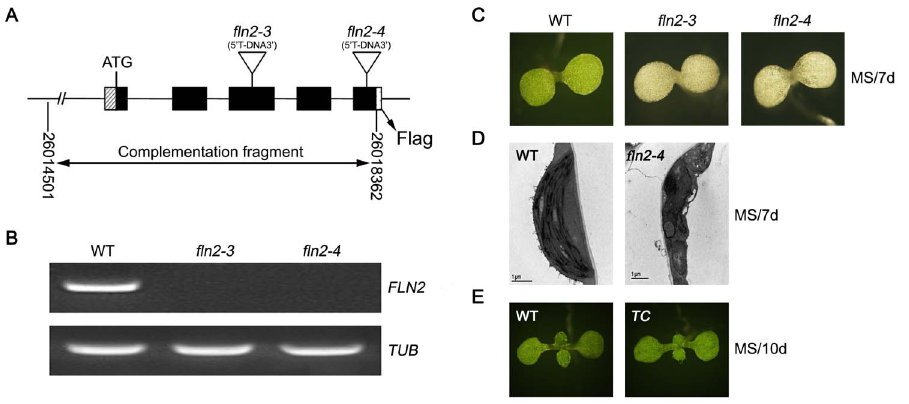
Figure 1. T-DNA insertion sites of fln2 and their phenotypes. (A) The sketch map of the FLN2 gene, the T-DNA insertion sites of fln2 mutants. Boxes, exons; lines, introns. (B) The expression of FLN2 in WT (Col-0), fln2–3 and fln2–4 . (C) Photographs of the fln2–3 and fln2–4 seedlings grown on MS medium for 7 days. (D) Ultrastructural analysis of chloroplasts from 7-day-old WT and fln2–4 seedlings grown on MS medium. Scale bars: 1 m m. (E) Phenotypes of WT and the fln2–4 complemented seedlings grown in soil.